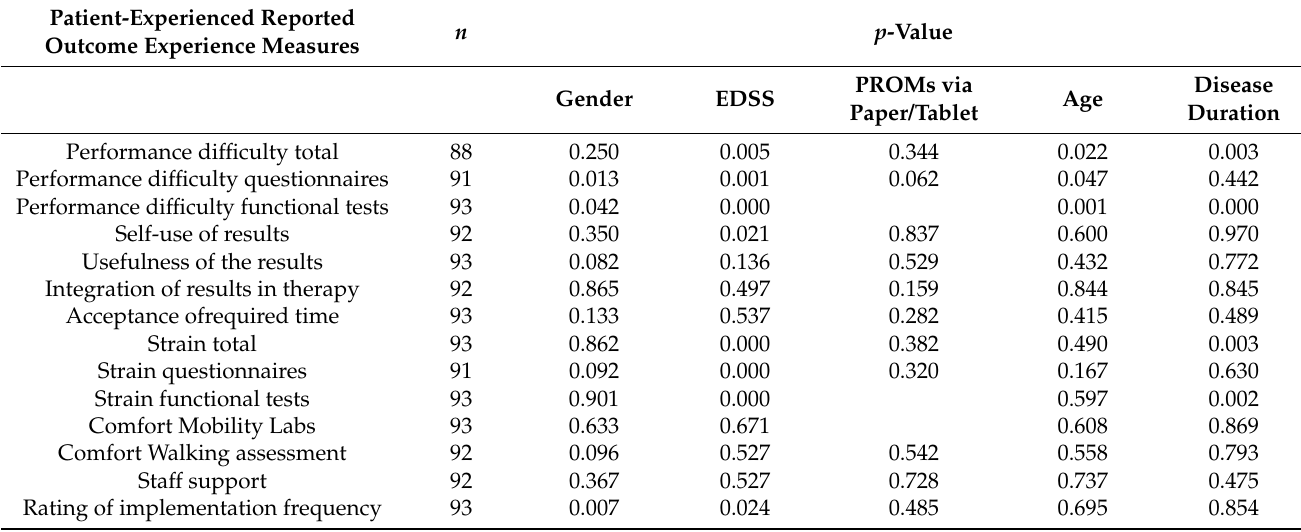
Table 9. Model effects for patient-reported experience measures, demographic, and clinical data ( N =